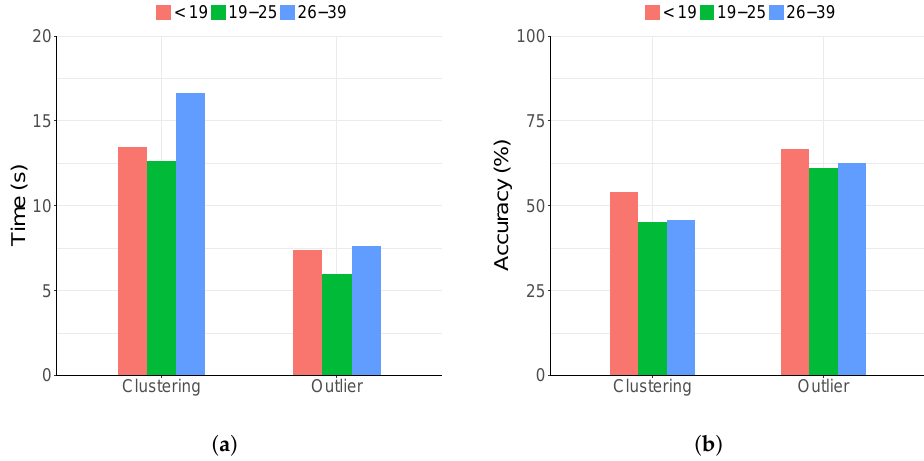
Figure 10. Performance in different age groups and tasks. ( a ) Completion time; ( b )